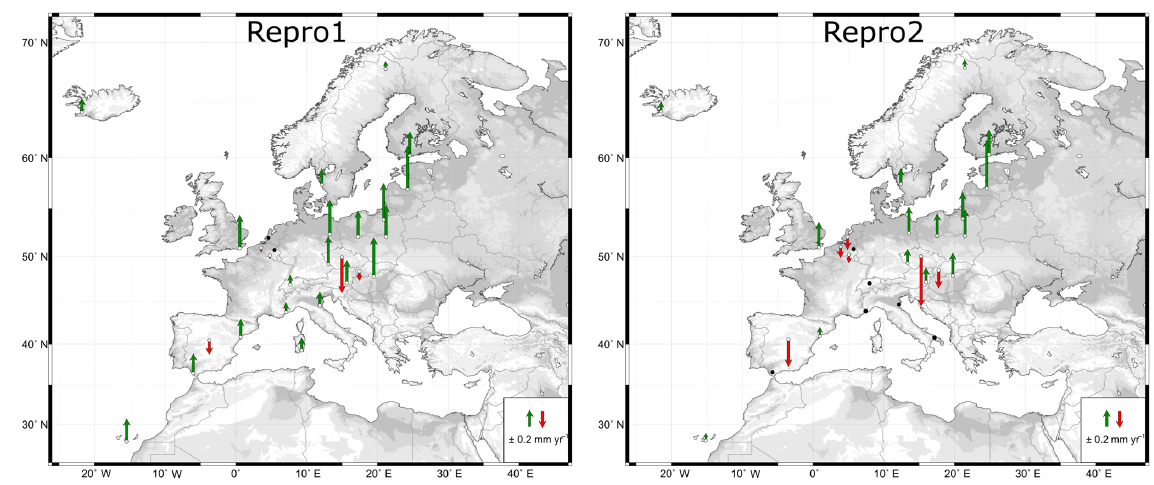
Figure 7. ZTD trend for the 18-year time series (January 1996 to December 2013) obtained from the Repro1 campaign (left) and ZTD trend for the 18-year time series (January 1996 to December 2013) obtained from the Repro2 campaign